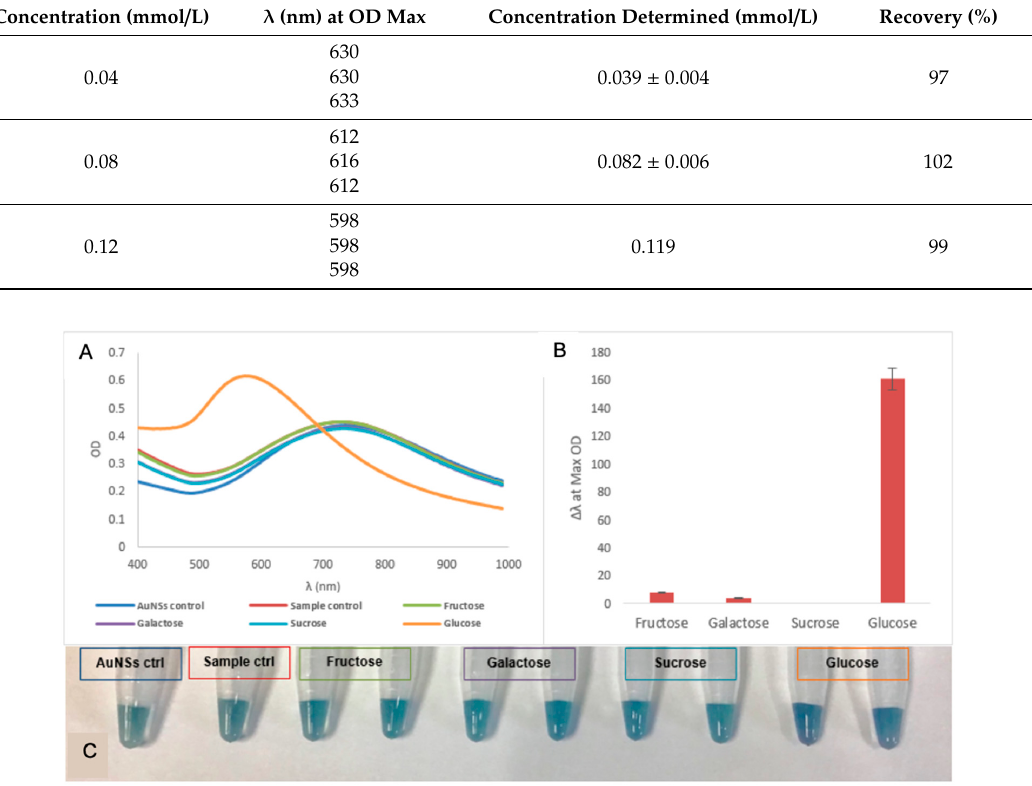
Figure 7 . ( A ) UV-vis spectra of the specificity of the glucose biosensor in the presence of other saccharides at 0.1 mM concentration; ( B ) corresponding response in terms of Δ λ at OD Max for each saccharide for the glucose biosensor; ( C ) photograph of the change in colour for the various saccharides.